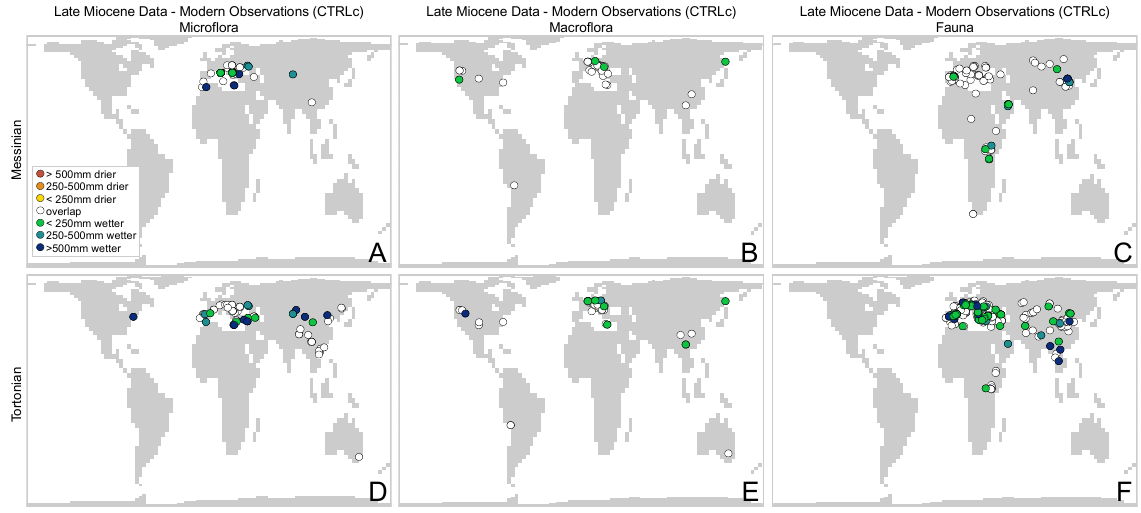
Fig. 11. Results from the model–data comparison for mean annual precipitation, late Miocene data–modern potential natural climate esti-